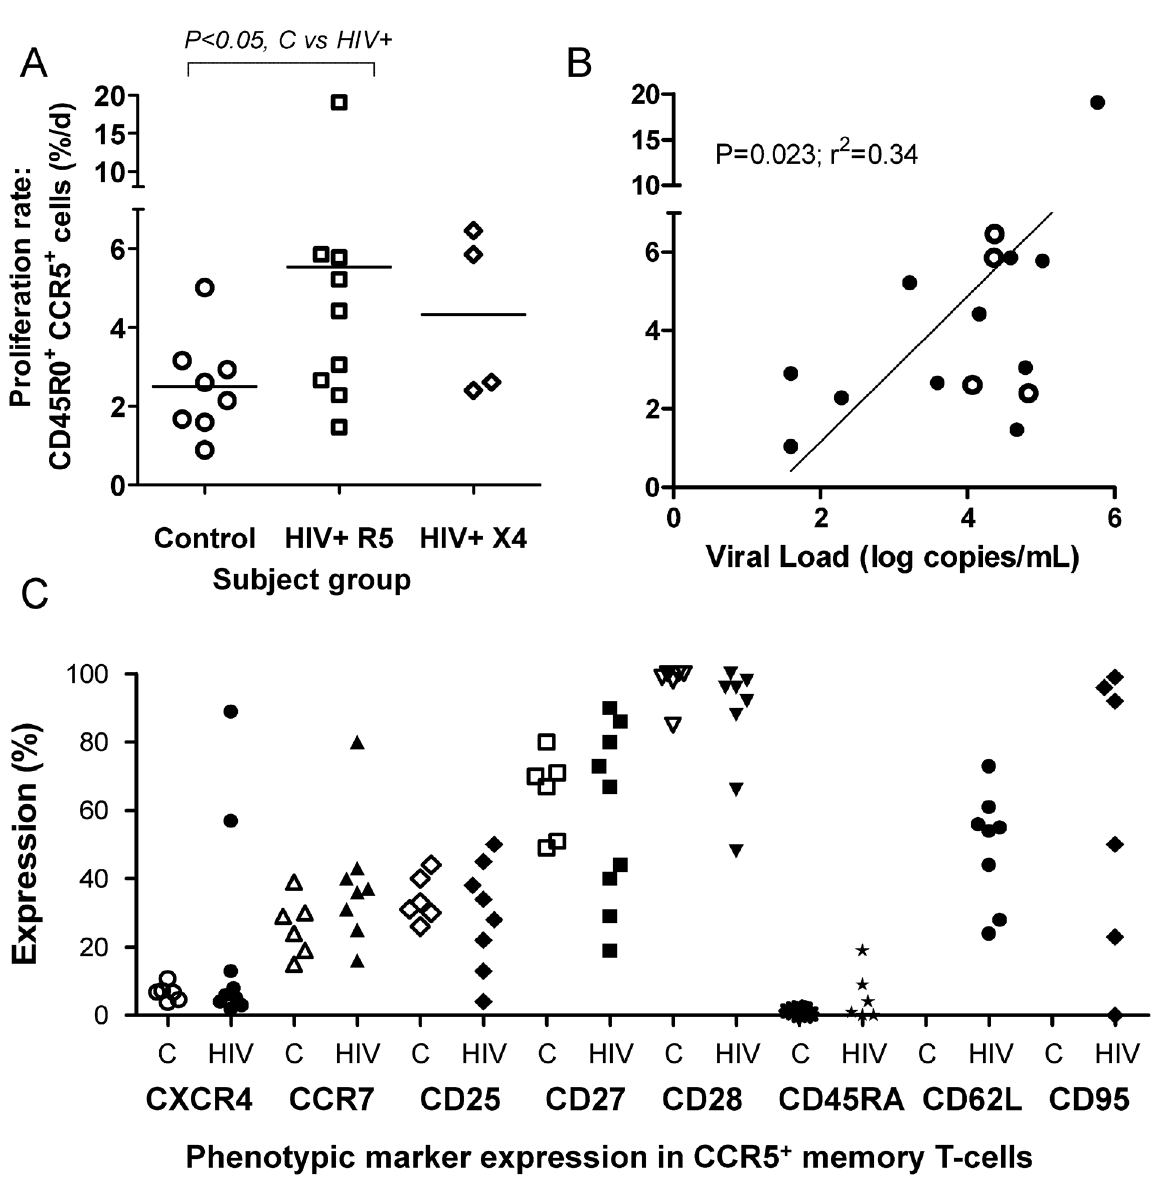
Figure 2. HIV infection accelerates turnover rates of CCR5-positive CD4 + CD45R0 + memory T-cells. (A) Increased proliferation rates in HIV infected subjects (HIV + R5, HIV-positive subjects with R5-tropic virus; HIV + X4, HIV-positive subjects with X4-tropic virus) compared to controls (P , 0.05 by Mann Whitney test as data skewed). (B) Correlation of CCR5 + T-cell turnover with viral load in viremic HIV + subjects (open circles are subjects with X4-tropic virus; P=0.044, r 2 =0.28 using log-transformed data). (C) Phenotype profile of CCR5 + memory T-cells in healthy controls (C, open symbols) and HIV + subjects (H, filled symbols). CD62L and CD95 data were not available for control subjects. P=NS for all comparisons between control and HIV + by Mann Whitney